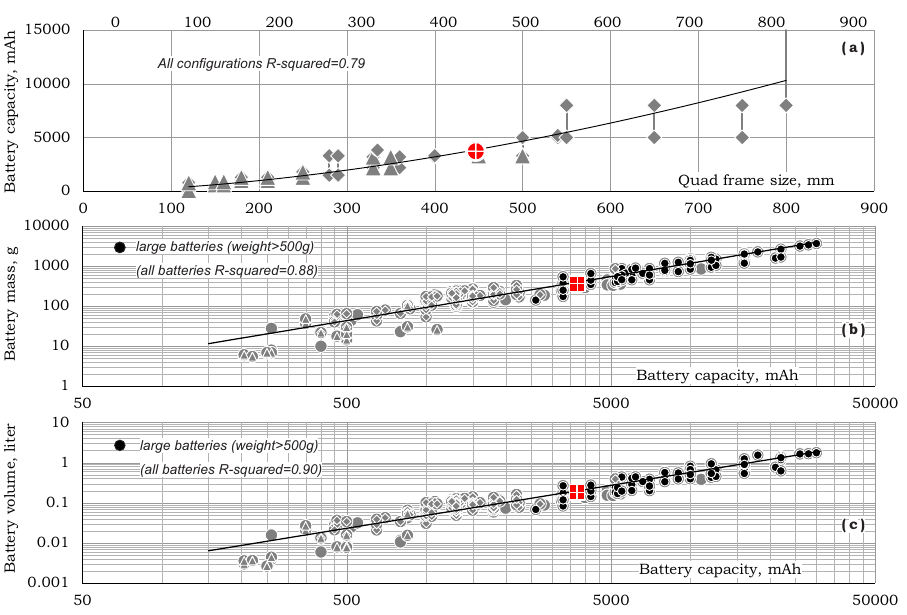
Ω [ RPM ] does not practically KV · U [ Volt ]